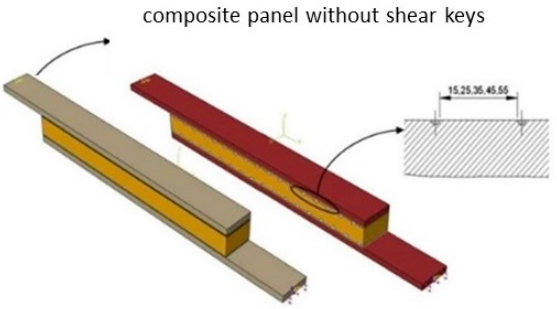
Figure 9. Investigated composite panel with and without shear keys by Mostafa. Adapted from [41].